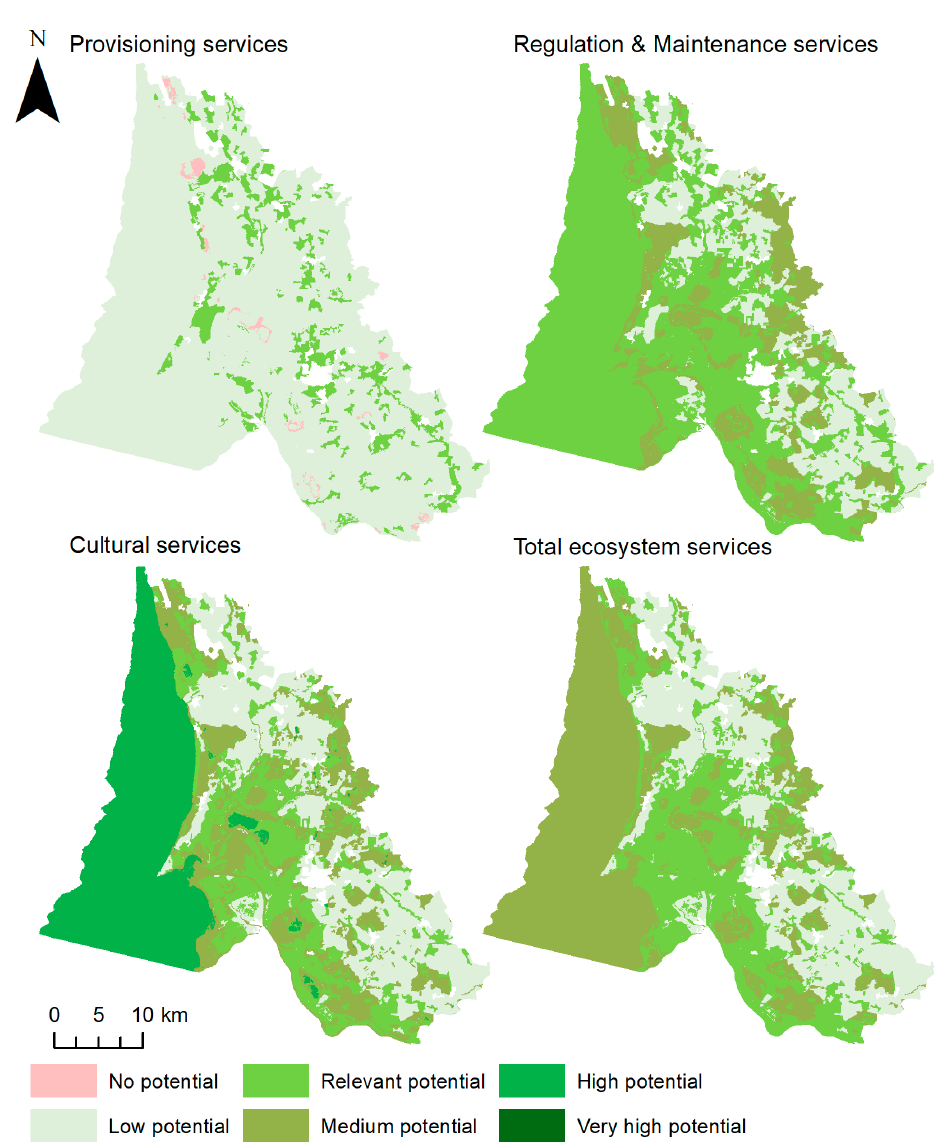
Figure 5. Maps of the ecosystem service potentials grouped into the ecosystem service categories in the Nemunas Delta and Curonian Lagoon region: provisioning services, regulation and maintenance and cultural services. The average data from the expert evaluations for each ecosystem service category were taken and final values were rounded to the nearest integer.